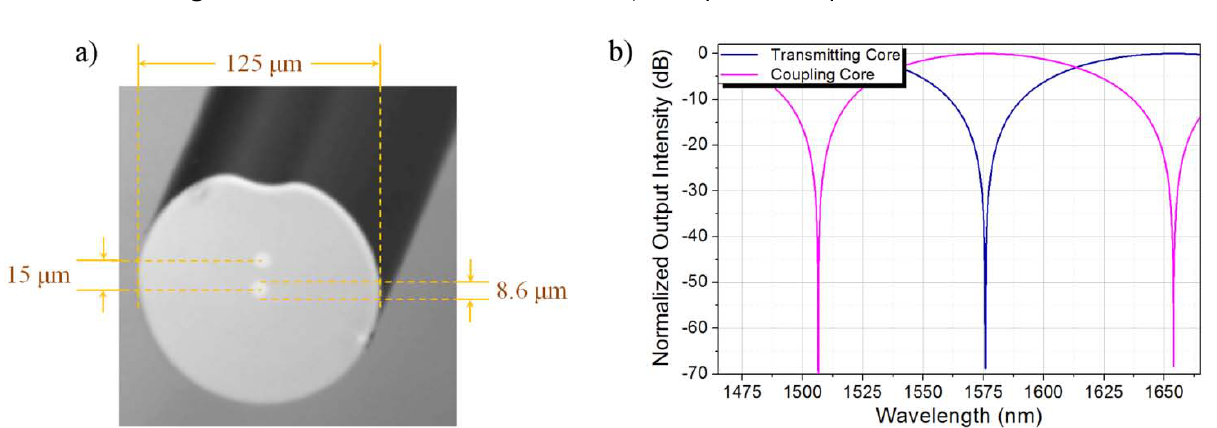
Figure 1. ( a ) Cross section of the TCF; ( b ) Spectral response of the